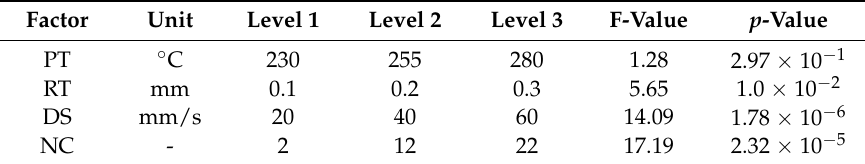
Table 7. ANOVA results for ULSF for ABS BM FDM.